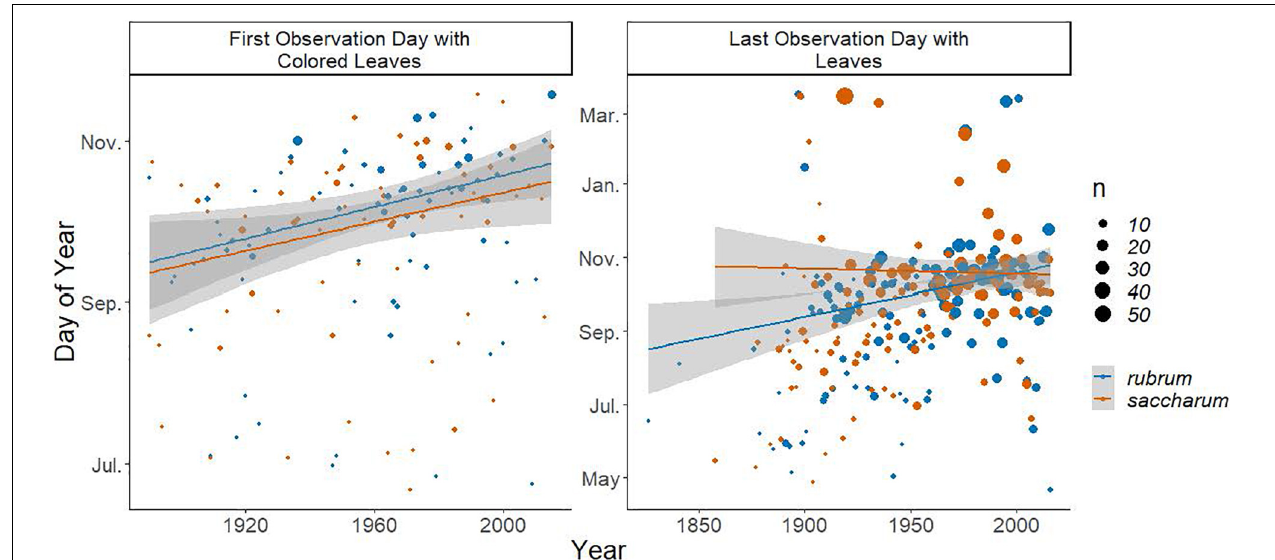
FIGURE 3 | Scatter plots of the first day of year between the approximate summer and approximate fall solstice when a specimen was recorded with colored leaves (left) and the last day of year from the spring equinox to the spring equinox of the following year when a specimen was recorded with leaves (right). Points are colored by the species and sized by the number of specimens collected during that period. Lines are best fit linear regressions with a shaded area indicating the 95% confidence interval and are fit independently to each